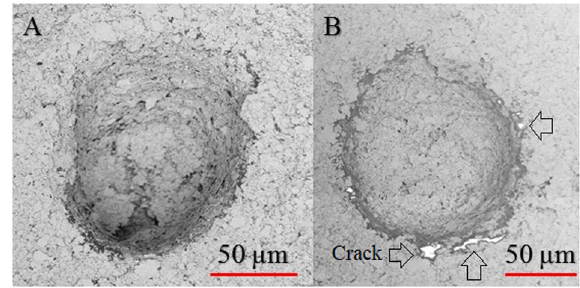
Fig. 4 Silver ink collar strain. SEM images of a before bent via and b after bent via. (sample set #2 via size; 100 μ m nominal via diameter, Asahi